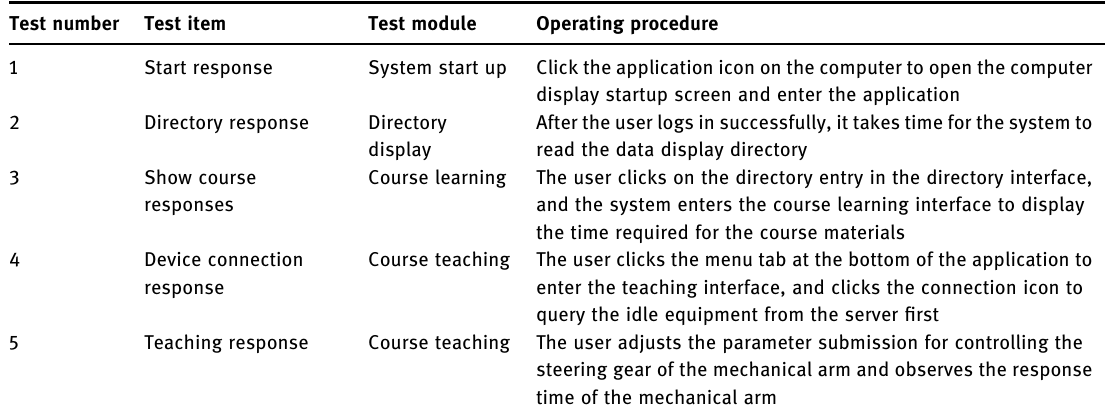
Table 4: Test item description